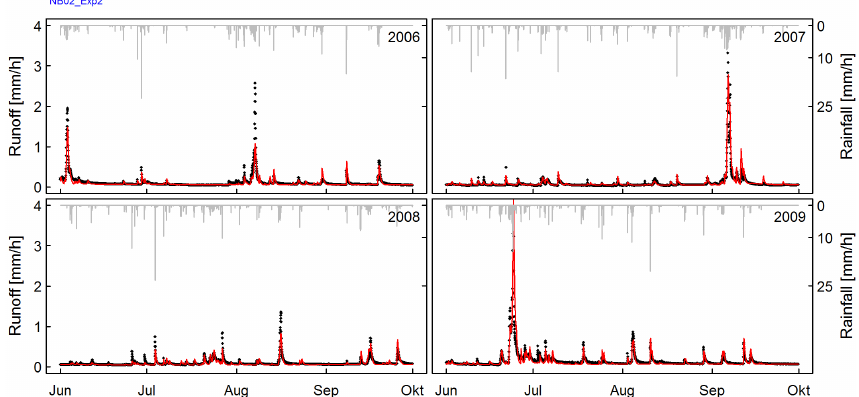
Figure 7. Krems catchment: observed (black points) and simulated (red) runoff of Exp 2